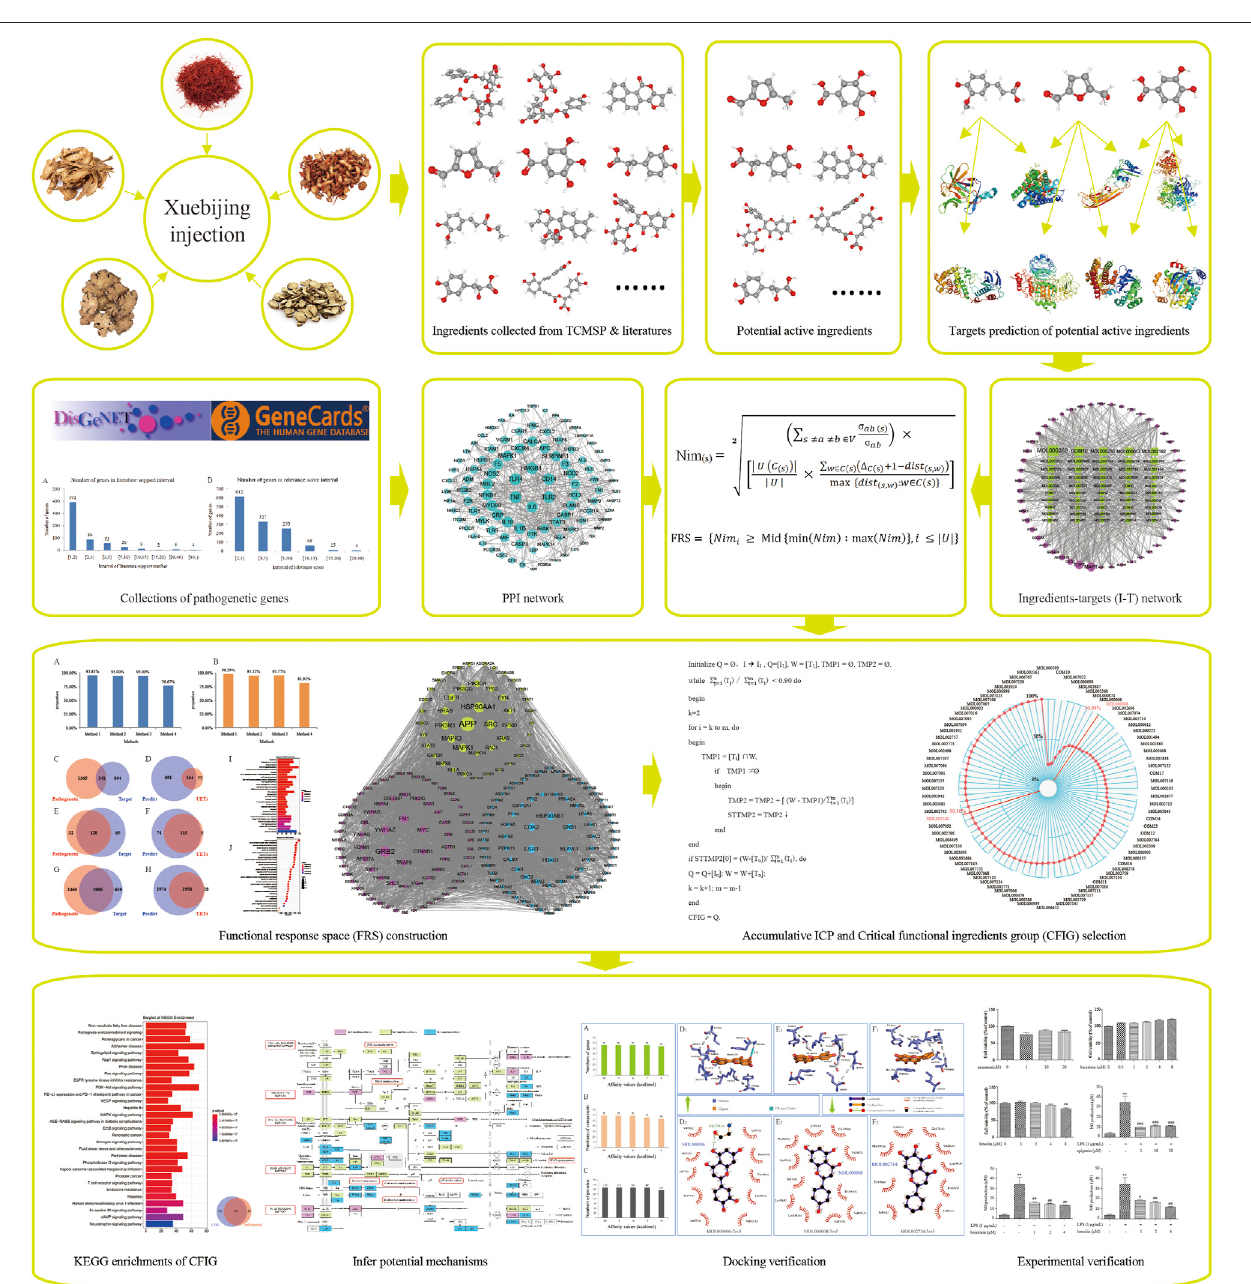
FIGURE 1 | The work scheme of network pharmacology